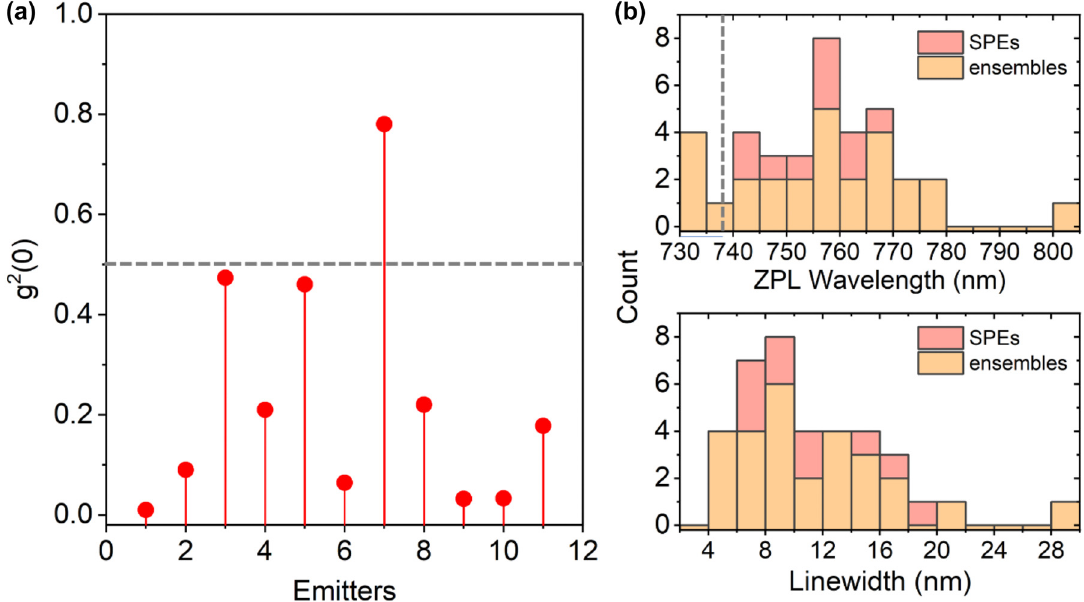
Figure 4: Statistics on g 2 (0), ZPL wavelength and linewidth of quantum emitters on sample D. (a) Distribution of Ga) Distribution of g 2 (0) values of 11 emitters found on sample D that show antibunched emission ( g 2 (0) < 1). (b) Histograms of ZPL wavelengths (top) and linewidths (bottom) of 37 emitters from sample D. The data include both SPEs (red) and emitter ensembles (yellow). As a reference, the dashed gray line in the top panel of (b) indicates the typical emission wavelength of SiV − centers in bulk diamond at room temperature (738